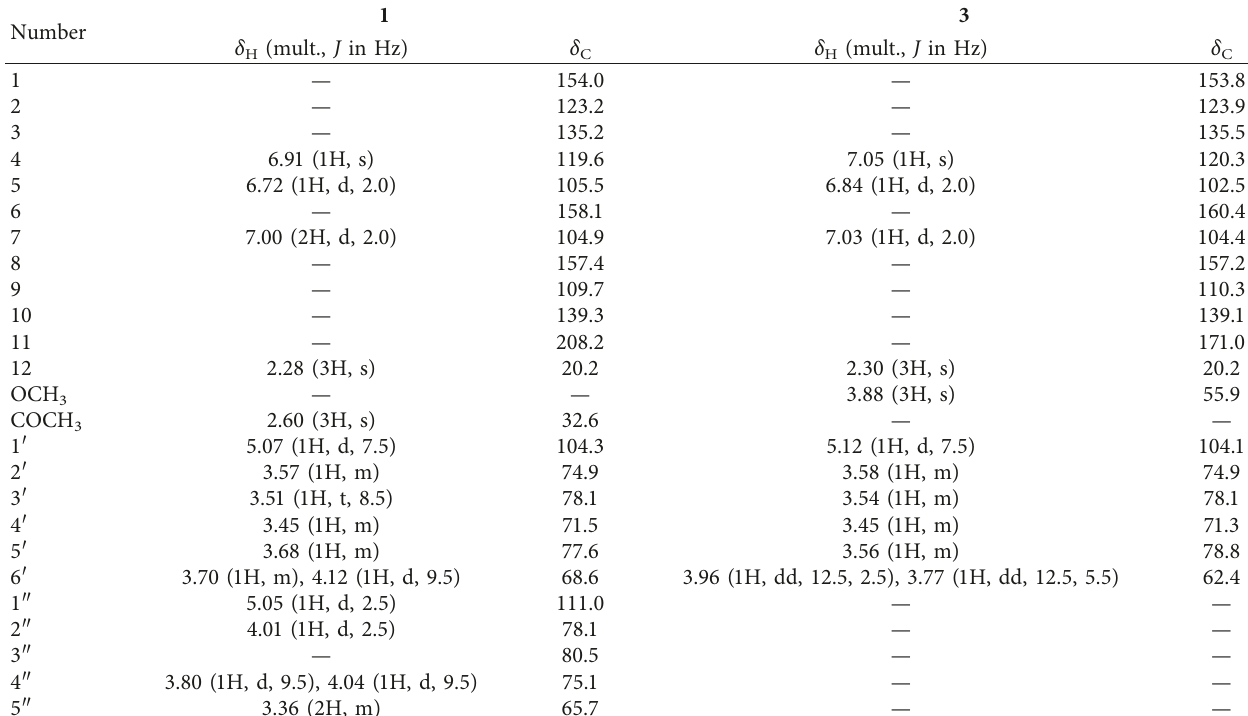
Table 1: NMR data of compounds 1 and 3